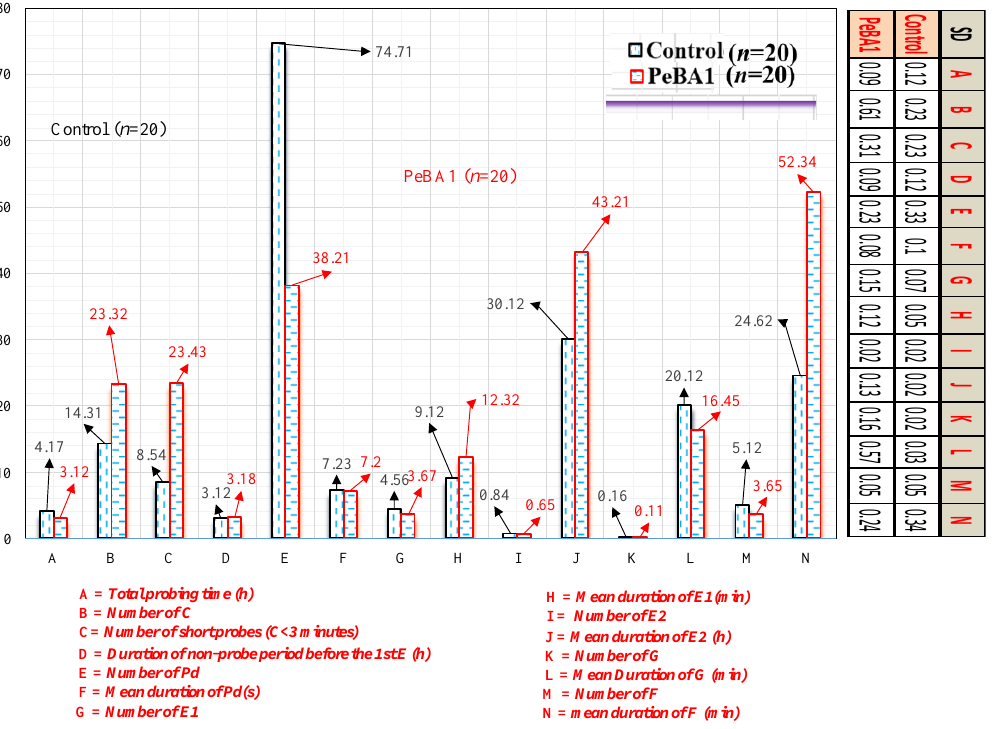
Figure 4. EPG data of B. brassicae on PeBA1-treated and control seedlings (mean ± SD). C indicates pathway activities, Pd represents potential drop, E2 represents phloem-feeding activities, F repre- sents penetration difficulty, G represents xylem-feeding activities, and E1 represents saliva injection. Independent t -test with two tails was used to compare data ( p = 0.05) .